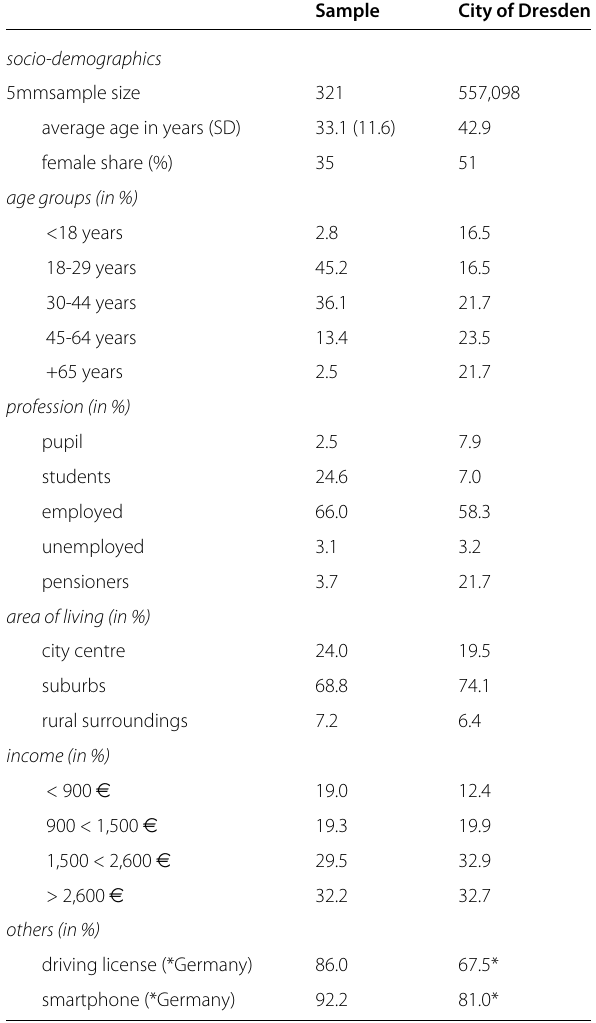
Table 3 Specifics of the sample compared to the city of